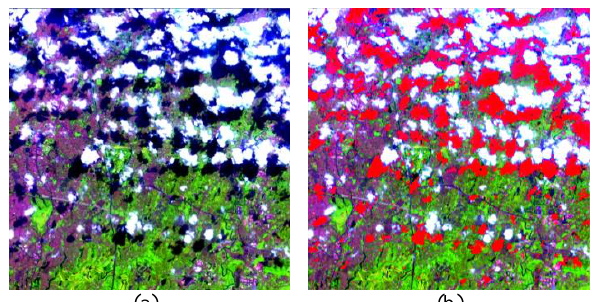
Figure 10. The result of cloud shadow masking. Red colour indicates cloud shadow region.